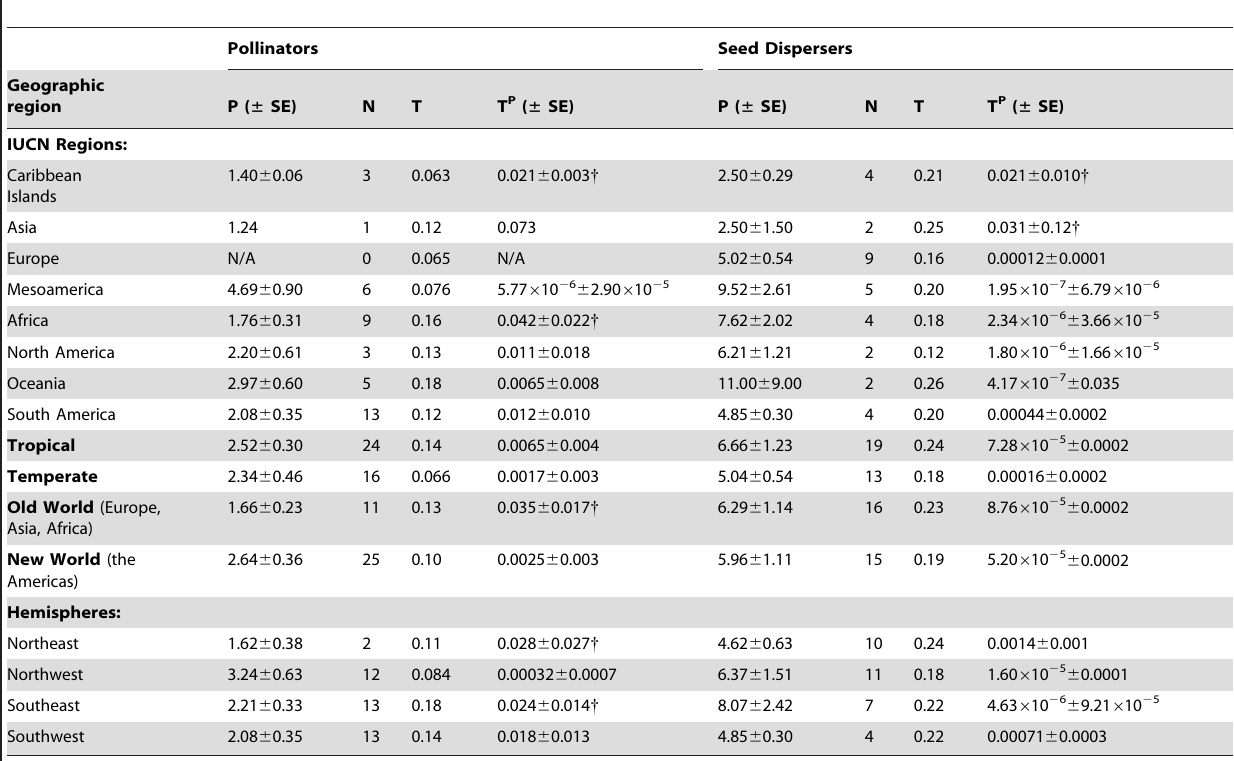
Table 2. Average number of vertebrate partners per plant (P), proportion of vertebrate partners that are threatened with extinction (T), and proportion of total vertebrate-mutualist plants at risk of losing all vertebrate partners (T P ), by geographic